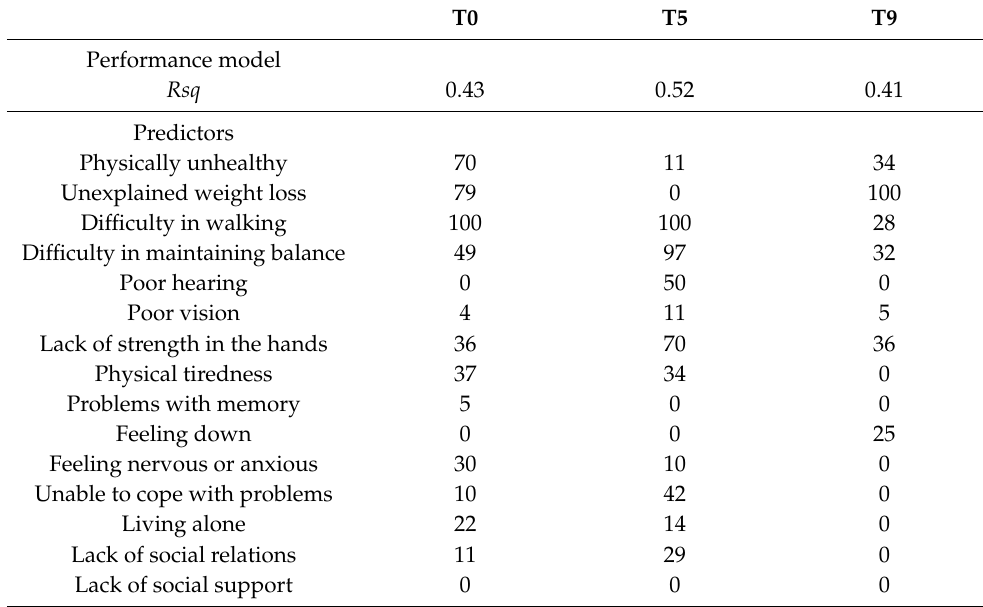
Table 5. Rsq -values and relative importance TFI items for the ADL disability scores.